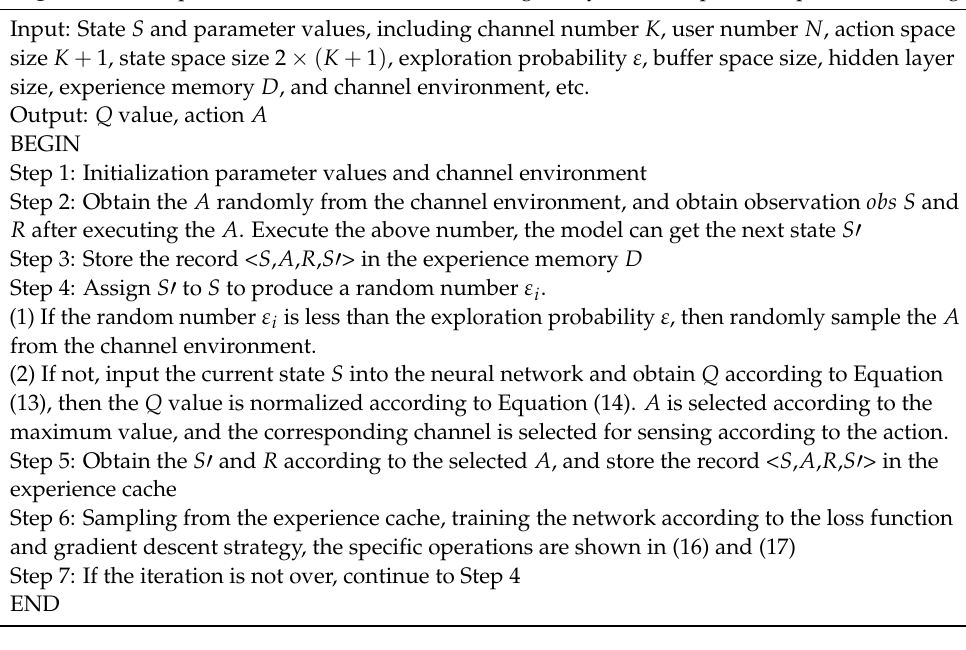
Algorithm 2 Deep multi-user reinforcement learning for dynamic cooperative spectrum